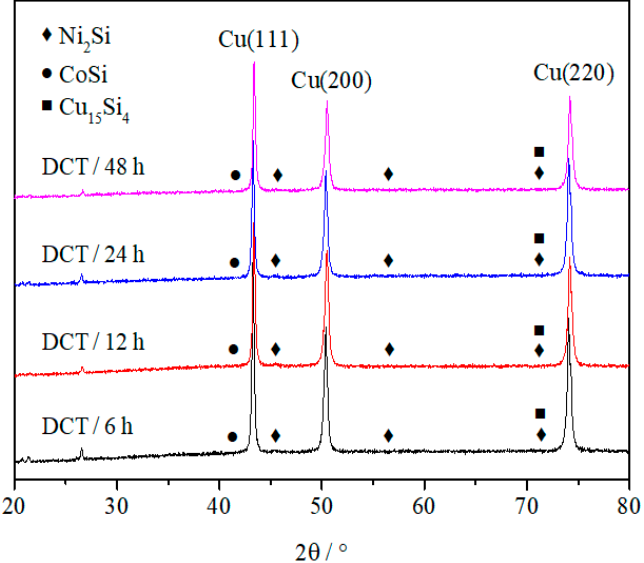
Figure 9. X-ray diffraction analysis of the Cu-1.34Ni-1.02Co-0.61Si alloy after cold rolling at 47% reduction with the DCT in liquid nitrogen for 6 h, 12 h, 24 h and 48 h.